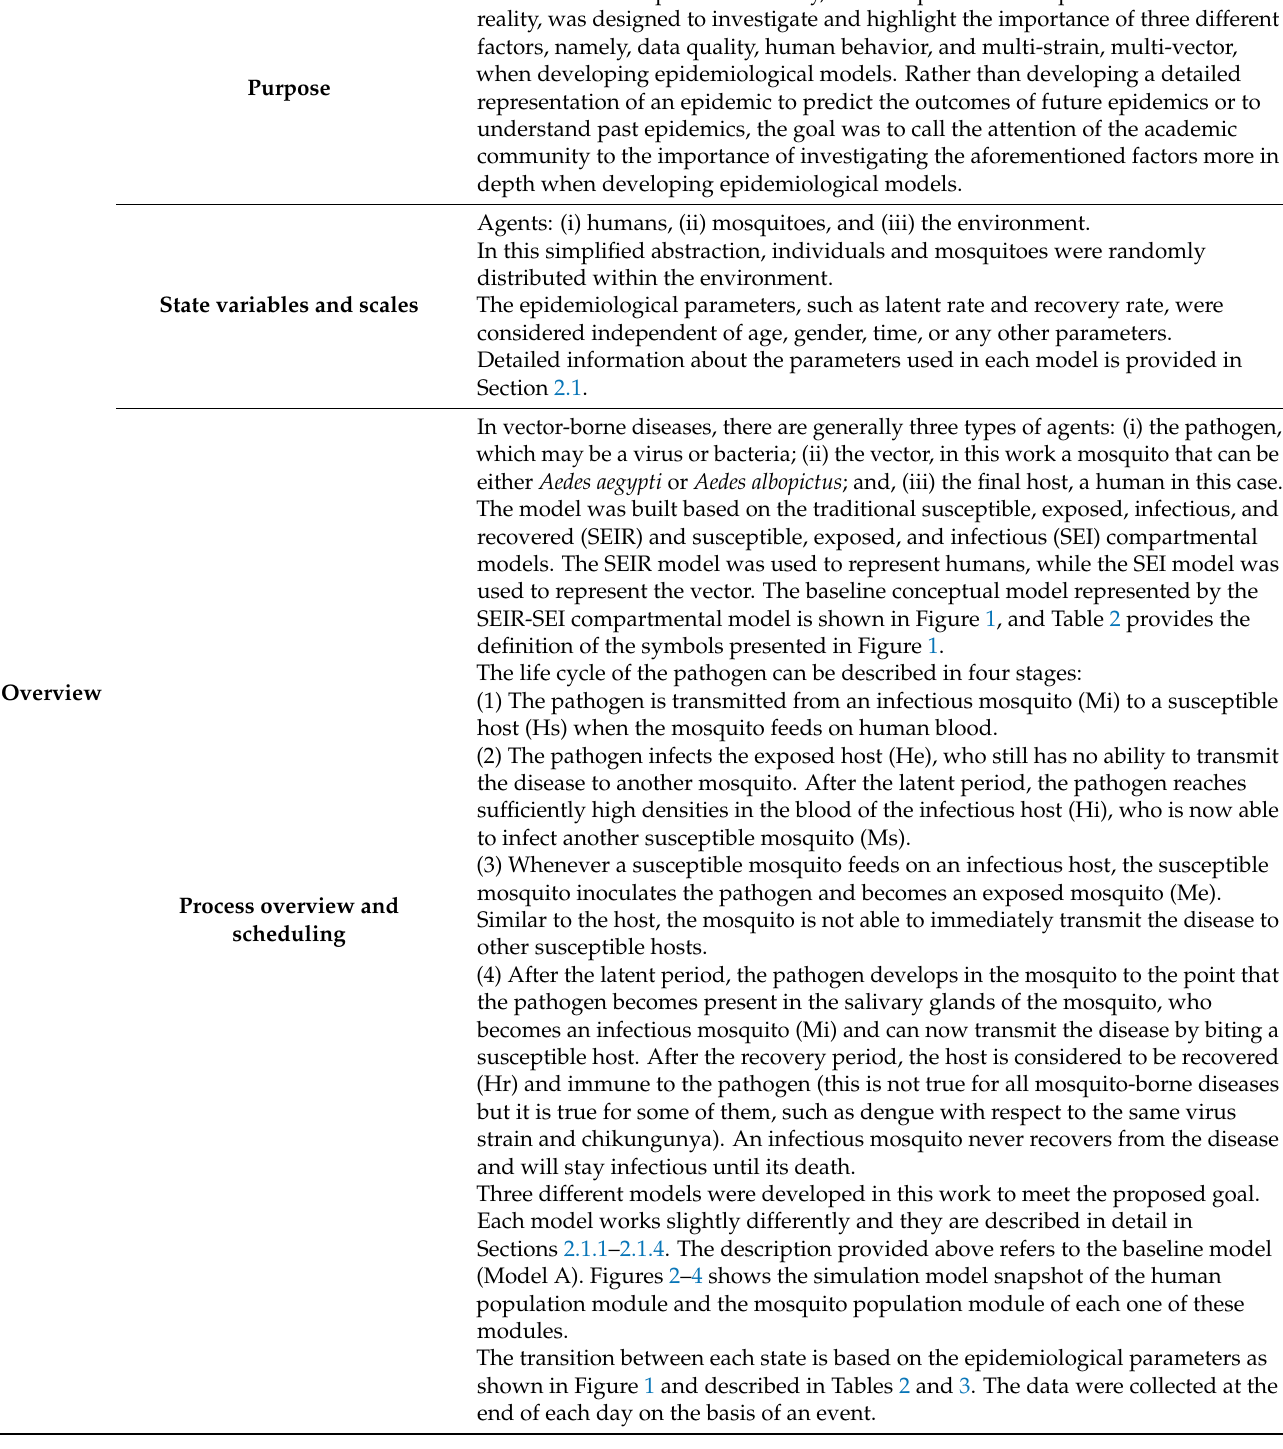
Table 1. Overview, design concepts, and details protocol for the study.